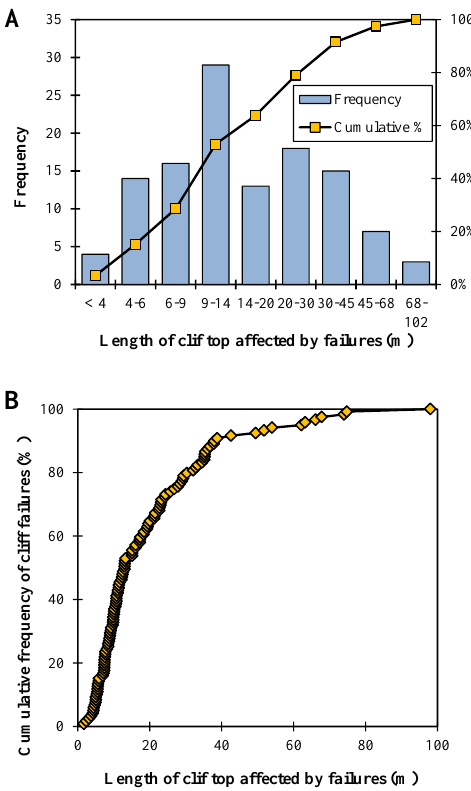
Fig. 5. Length of cliff top affected by sea cliff failures ordered Figure 5. Length of cliff top affected by sea cliff failures ordered by increasing order of 3 by increasing order of values. (A) Histogram of cliff top length values. A) Histogram of cliff top length affected by cliff failures and corresponding 4 affected by cliff failures and corresponding cumulative frequency curve. Class limits based on a 1.5 × progression. (B) Cumulative cumulative frequency curve. Class limits based on a 1.5x progression. B) Cumulative 5 frequency plot of cliff top length affected by cliff frequency plot of cliff top length affected by cliff failures. 6